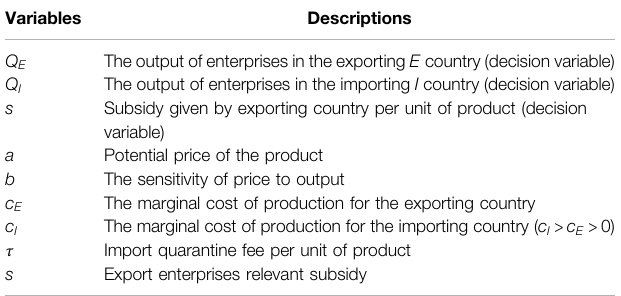
TABLE 1 | Model notations and